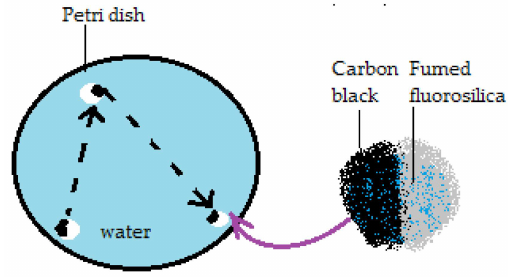
Figure 12. Self-propelled Janus liquid marbles’